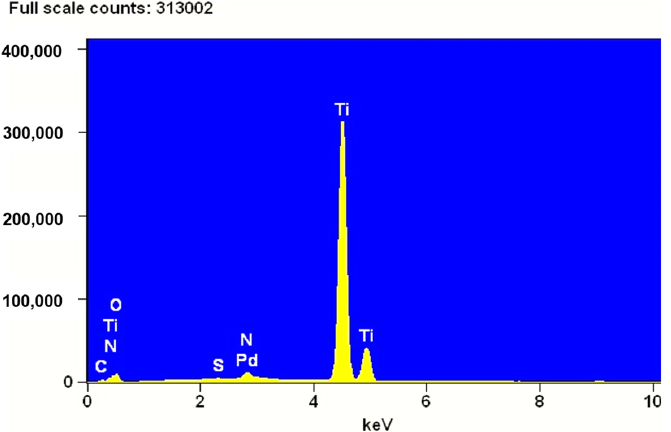
Figure 12. Energy dispersive spectrum of Pd/TiO 2 /Ti catalyst obtained with adsorption of Pd ions from 2%Pd wt. solution.